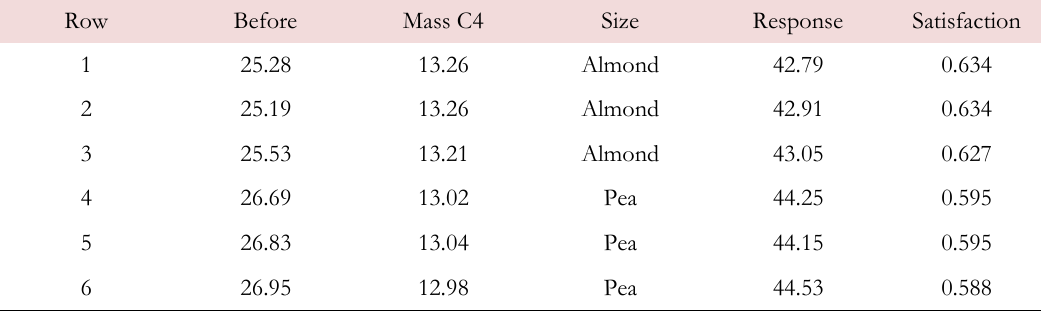
Table 13: The values of the optimized points in the experimental test. .